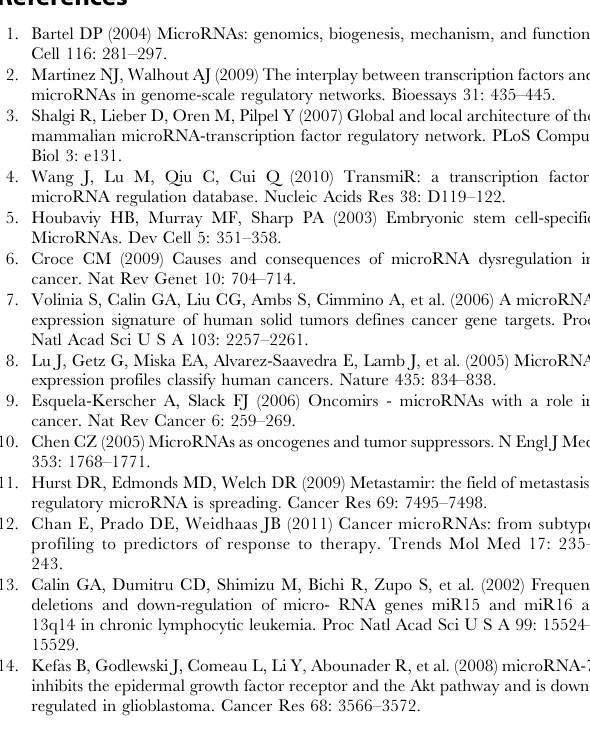
Figure S6 Analysis of correlation change in ovarian cancer. (A) Focusing on our set of 99 overall important miRs (OIM), we indicated if such miRs were linked to differentially expressed pathways in ovarian cancer (peach boxes). We observed a large cluster that corresponded to down regulated pathways (orange box). In (B) we calculated the change of expression correlation, D Z, for all pairs of OIMs in this cluster and the interacting leading edge genes in the corresponding pathways, indicating local peaks around D Z = 6 1.0 (dashed lines). In (C) we mapped all such interactions between OIMs and leading edge genes if they had a correlation change | D Z| . 1.0. Figure S7 Analysis of correlation change in breast cancer. (A) Focusing on our set of 99 OIMs, we indicated if such miRs were linked to differentially expressed pathways in breast cancer (peach boxes). Specifically, we observed two large clusters that corresponded to either up- or down regulated pathways (orange, green boxes). In (B) we calculated the change of expression correlation, D Z, for all pairs of OIMs in such clusters and their interacting leading edge genes in the corresponding pathways. Specifically, we observed multimodal distributions with local peaks around D Z = 6 1.0 (dashed lines). In (C) and (D) we mapped all such interactions between OIMs and leading edge genes in these clusters if they had a correlation change | D Z| . 1.0. Table S1 Utilized miR-mRNA interactions. List of all 48,393 interactions between miRs and genes, that have been confirmed by two different sources (M: miRanda, P: PicTar, T: TargetScan). Table S2 Pairs of significantly associated miRs and pathways in glioblastomas. 265 pathways that were signifi- cantly associated to miRs in glioblastoma. Each pathway is annotated with its leading edge genes and important miRs. P-